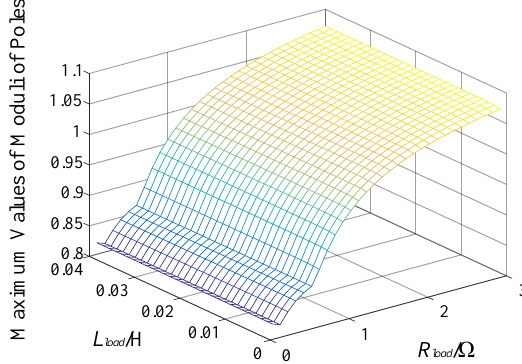
Figure 12. Maximum values of moduli of poles of T(z) with certain C load and variable RL load.